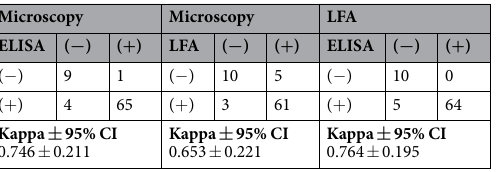
Nb44/Nb42 LFA (antigenaemia) and microscopy (parasitaemia). The ELISA and LFA scored positive for most infected mice and correlated relatively well with parasitaemia during the course of the infection (Fig. 6a). The positive score rates for LFA and microscopy were similar (although both did not always score negative on the same samples), while the positive score rate for ELISA was higher through-out the entire follow-up (Table 1).